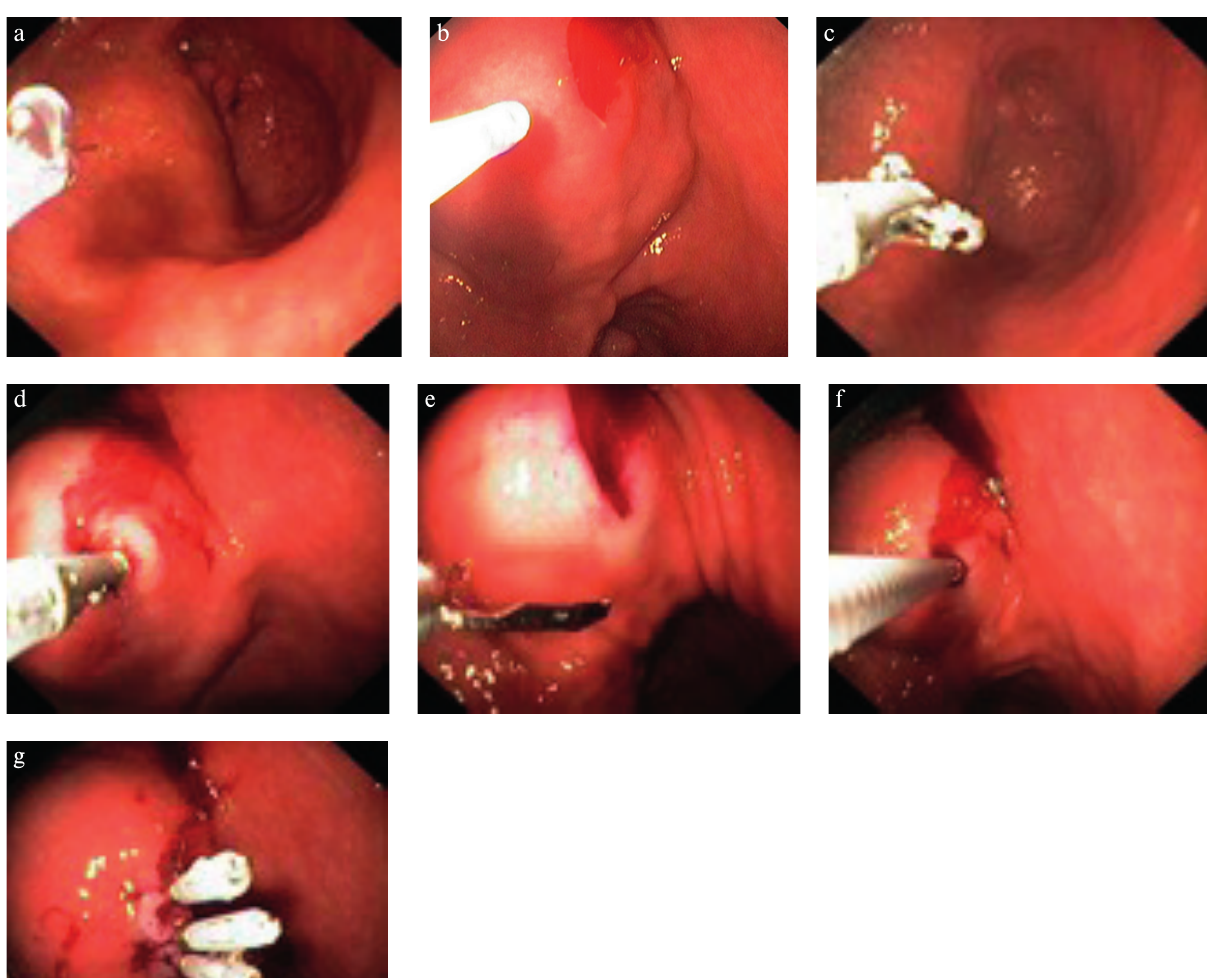
Fig. 4. Differents steps of Key Hole Biopsy. 4a. Pre-cutting knife before incision, 4b. Incision (KeyHole) maked by pre cutting knife, 4c. Opened forceps before biopsy, 4d. and 4e. Deep biopsy using forceps- samples are taken deeply, from different parts of the tumor, 4f. Opened endoscopic clips before closing the mucosal incision “Keyhole”, 4g. The closed “Keyhole” by endoscopic